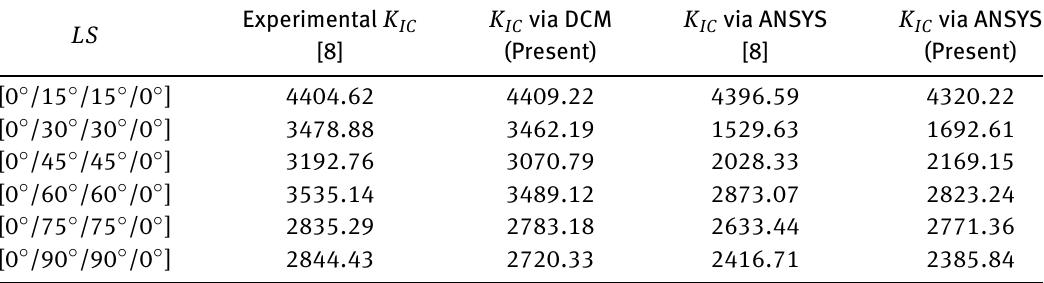
Table 4: Comparison of critical stress intensity factor ( K IC ) for different composite plate with present DCM. Experimental K IC LS